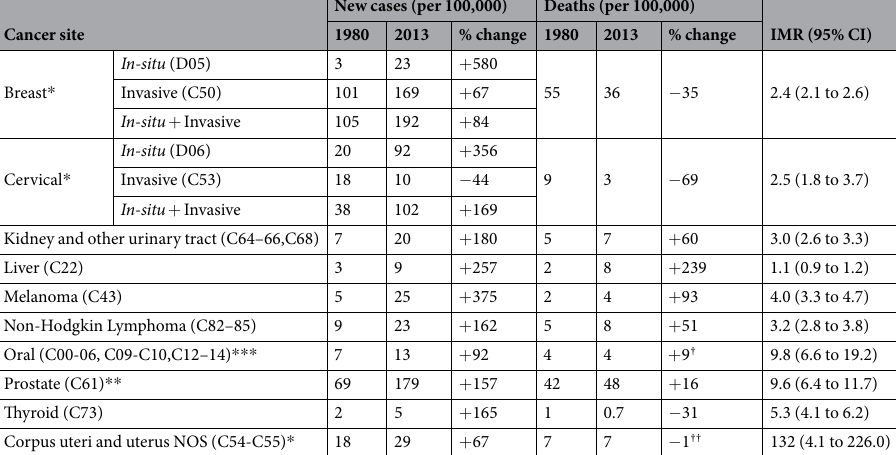
Table 1. European age-standardised GB incidence and UK mortality rates (per 100,000) for ten cancers for 1980 to 2013 in men and women, for women only * and men only ** . Figures for baseline (1980) and follow-up (2013) based on three-year averages for that period (1979–1981 and 2012–2014). *** 2013 estimate of incidence based on three-year average from 2011–13. IMR - incidence to mortality ratio. Significance tests for a change in deaths since baseline are all p < 0.001 except † p = 0.012 and †† = 0.76.